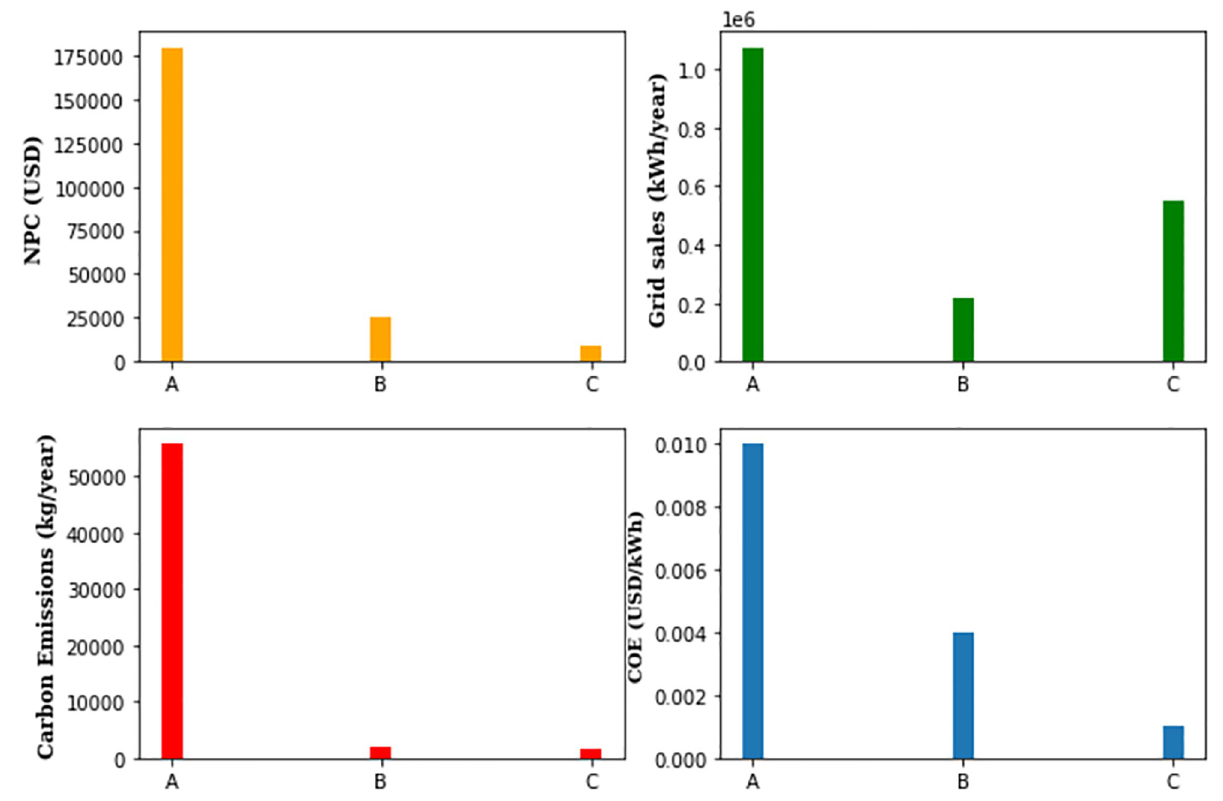
Fig 7. The comparative analysis of possible designs.